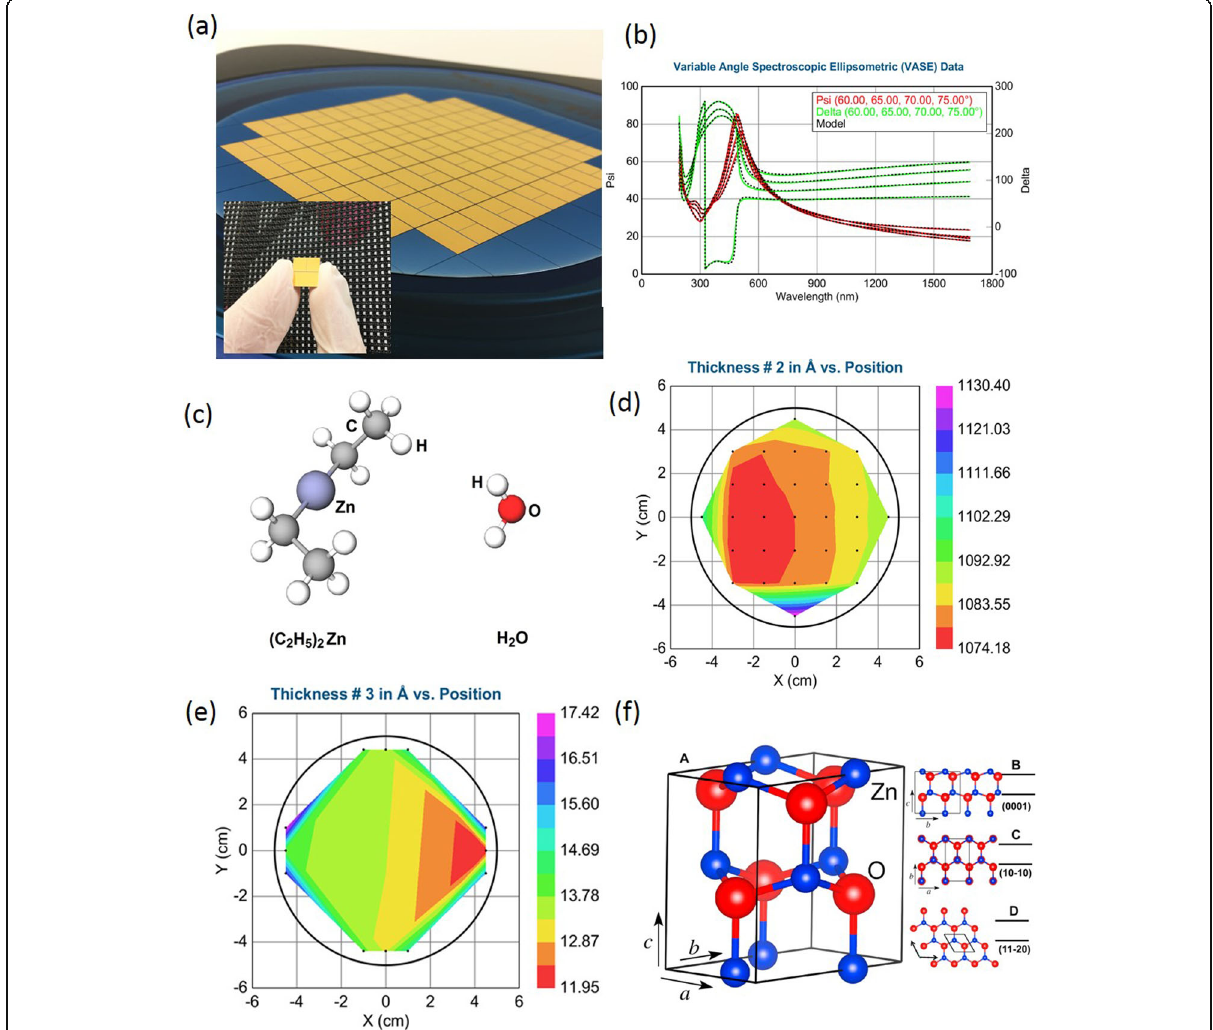
Fig. 1 a Angular optical image of the wafer-scale ALD deposited ZnO on Au electrodes with insert — an individual 1-cm 2 diced structure. b Experimental and model generated data for variable angle SE measurements of SiO 2 deposited on Si wafer. c Graphical scheme of (C 2 H 5 ) 2 Zn and H 2 O precursors, respectively. d SE mapping of the SiO 2 thickness in Å. e SE mapping of the thickness of ZnO films in Ångstrom on a 4-in. Si/SiO 2 wafer. f Unit cell of wurtzite ZnO with red — O and blue — ZnO atoms (panel a ). Atomic arrangement and (0001), (10-10) and (11-20) lattice planes B, C and D, respectively. The outline of the unit cell is shown as a black line. Reprinted from ref. [30] with permission from Elsevier